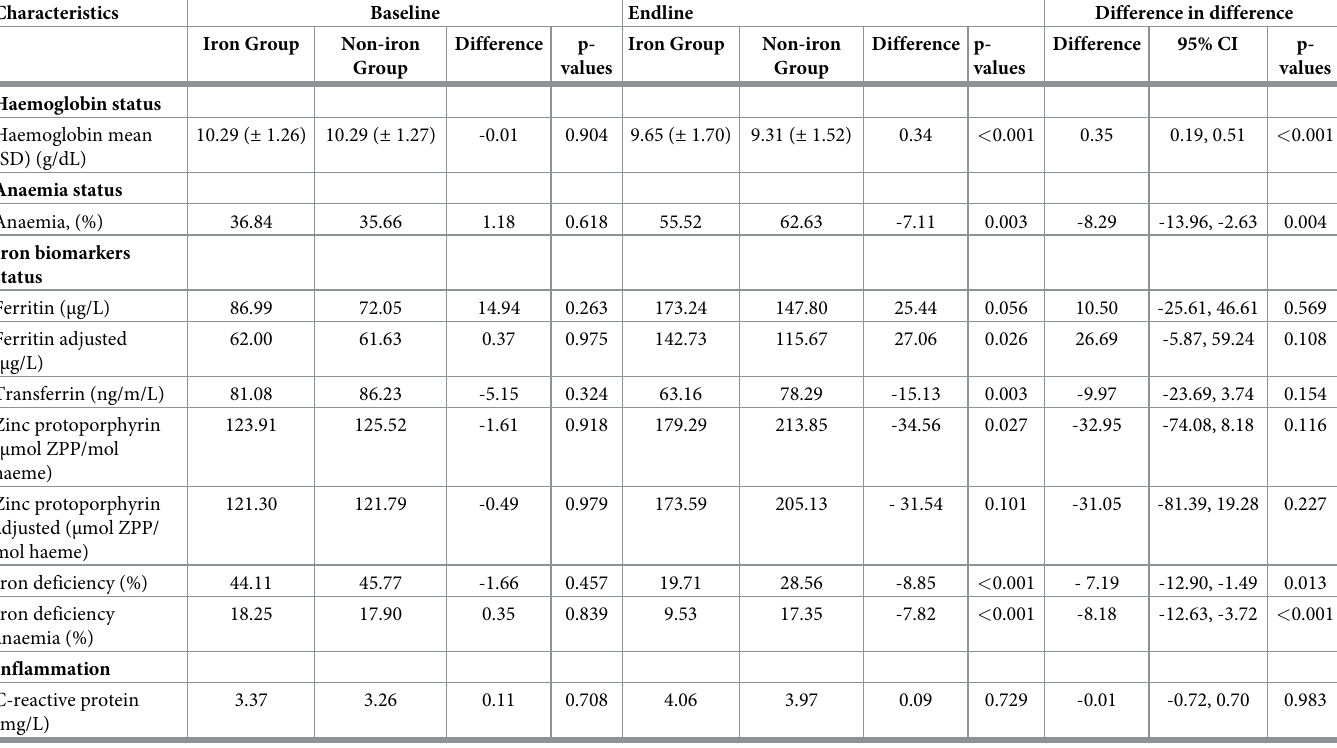
Table 4. Effect of MNP on haemoglobin, anaemia, iron biomarkers and CRP among study participants.